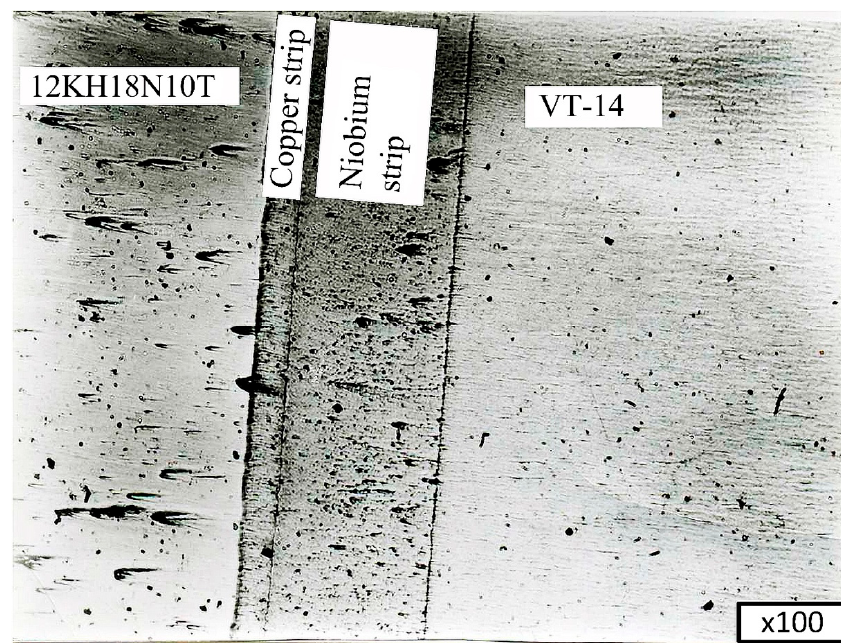
Figure 12. Microsection of welded solid-phase VT-14+Nb+Cu+12KH18N10T joint. Samples for tensile tests were pumped in from the welded samples, and the final groove of the samples to a diameter of 10 mm and 35 mm must be performed from tita- nium to steel.